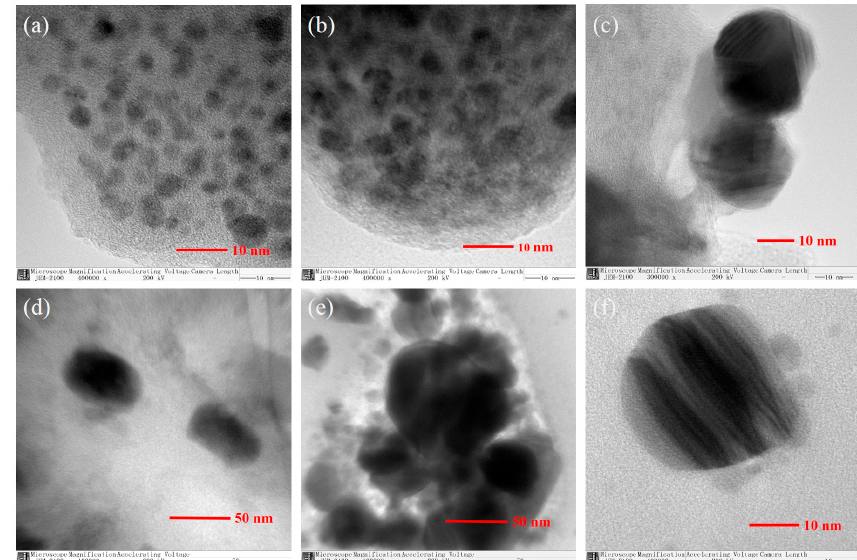
Figure 7. Transmission Electron Microscopy (TEM) images of the silver nanoparticles when the amount of AgNO 3 is ( a ) 10 mg; ( b ) 20 mg; ( c ) 30 mg; ( d ) 40 mg; ( e ) 50 mg, and ( f ) a single silver nanoparticle.